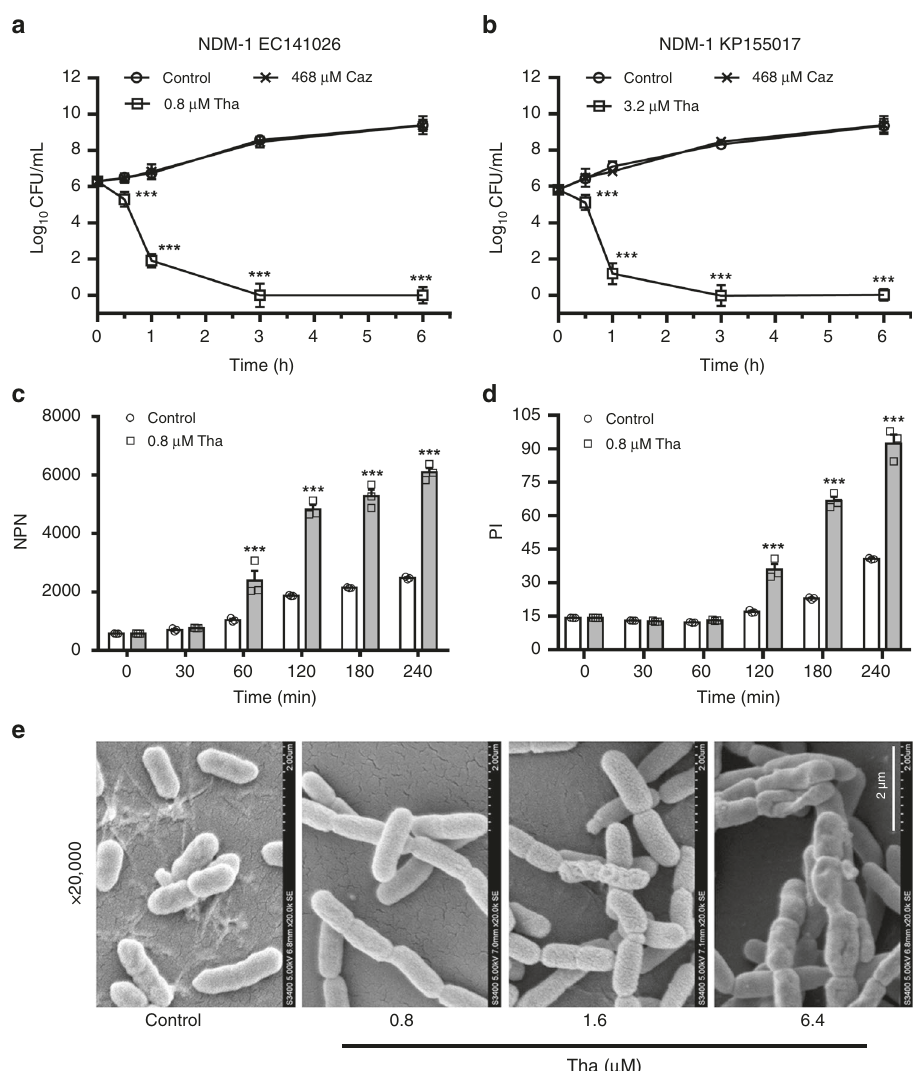
Fig. 1 Thanatin disrupts the integrity of bacterial membrane. a , b Kill curves of thanatin (Tha) and ceftazidime (Caz) against NDM-1-producing E. coli XJ141026 ( a ) and K. pneumoniae XJ155017 ( b ). Cell numbers were determined by plating for colony counts. c , d Outer and inner membrane permeabilization of thanatin was measured by detecting the fl uorescence intensity of NPN ( c ) and PI ( d ) in E. coli XJ141026. e Morphology of E. coli XJ141026 was investigated by scanning electron microscopy at 4 h after thanatin treatment. Scale bar = 2 μ m. All data are shown as the mean ± s.e.m. from three independent experiments. P- values were determined by two-way ANOVA; *** P < 0.001 vs. control. Source data are provided in Source Data fi